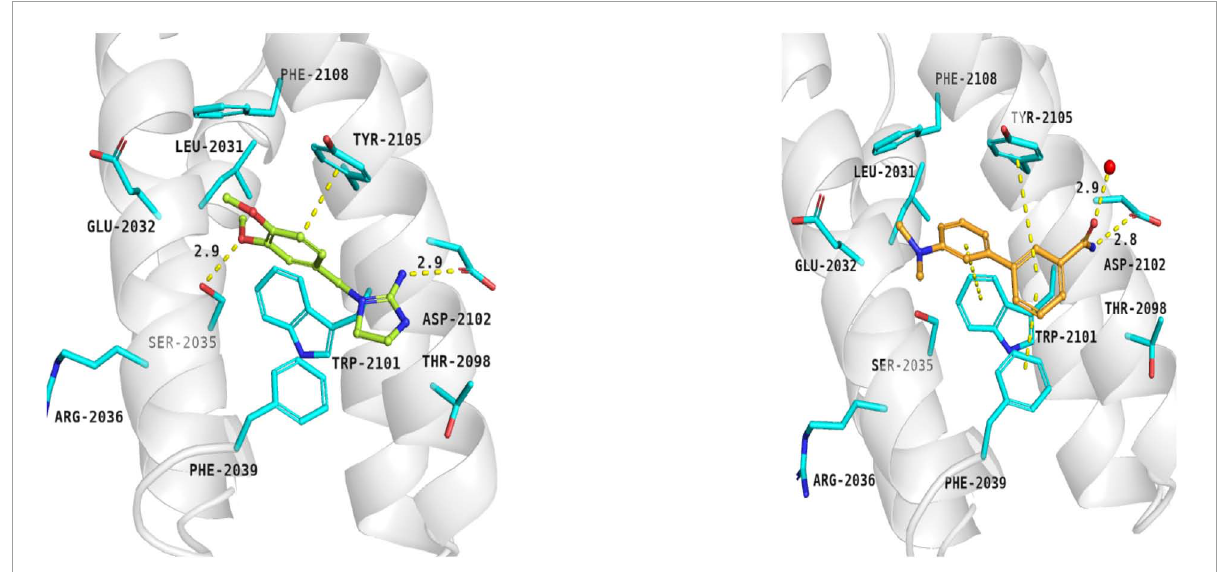
FIGURE3 Binding modes of compound 5 (left panel) and compound 6 (right panel) within the rapamycin binding site of mTOR. FRB domain – grey cartoon, water ions – red spheres. Selected interactions between ligands and residues colored as yellow